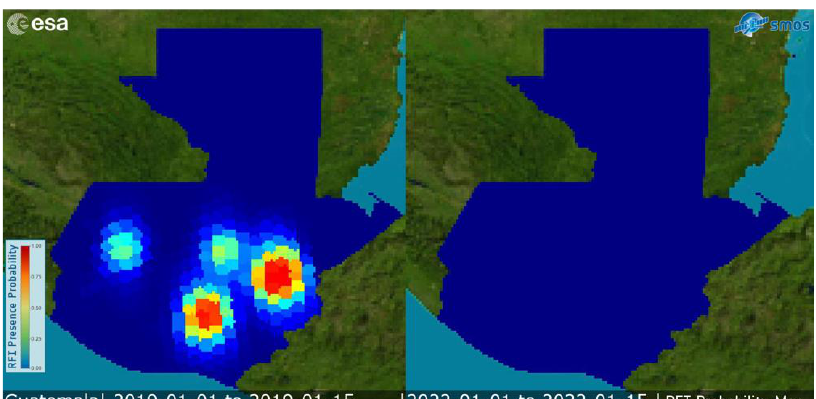
Figure 8. RFI probability map of Guatemala in January 2019 ( left ) and January 2022 ( right ) showing differences before and after reporting and shutting down detected RFI sources.